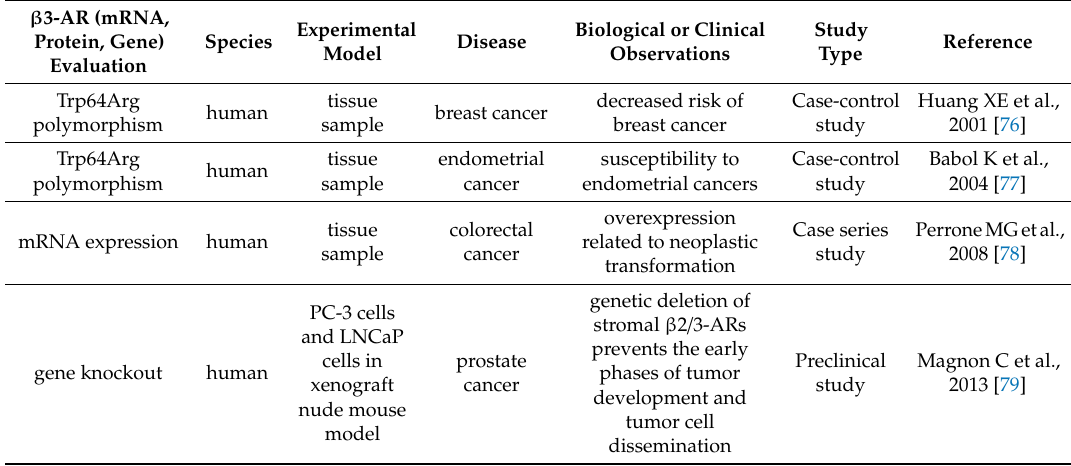
Table 1. Studies Describing β 3-AR Involvement in the Development of Di ff erent Cancers. β 3-AR (mRNA, Protein,